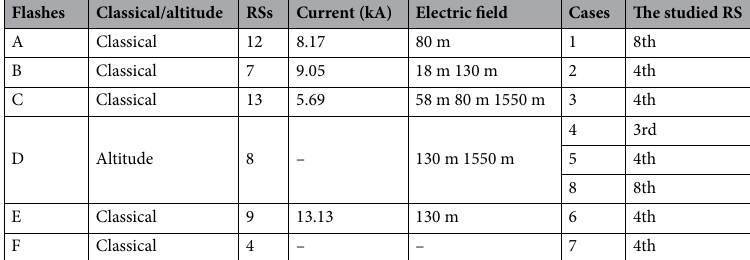
Flashes Classical/altitude RSs Current (kA) Electric field Cases The studied